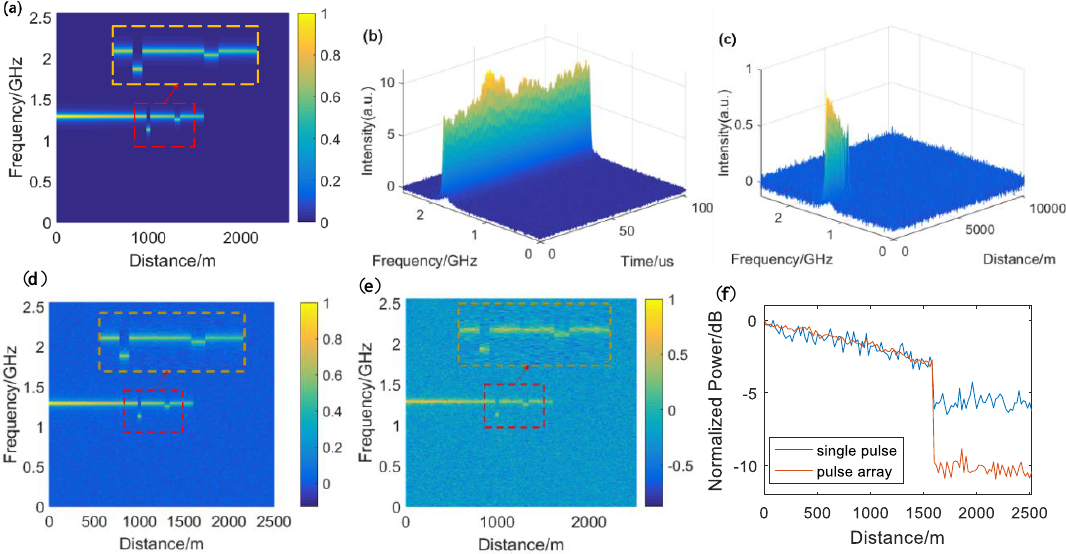
Figure 3. Simulation results. ( a ) Set impulse response matrix without noise, using two irregular Brillouin frequency shift (BFS) points; ( b ) simulated received output signal generated by the sensing system with pump array input; ( c ) calculated impulse response matrix; ( d ) calculated impulse response matrix with pump array input; ( e ) calculated impulse response matrix with single pump pulse input; ( f ) simulated trace for single pump pulse and pump pulse array input case.